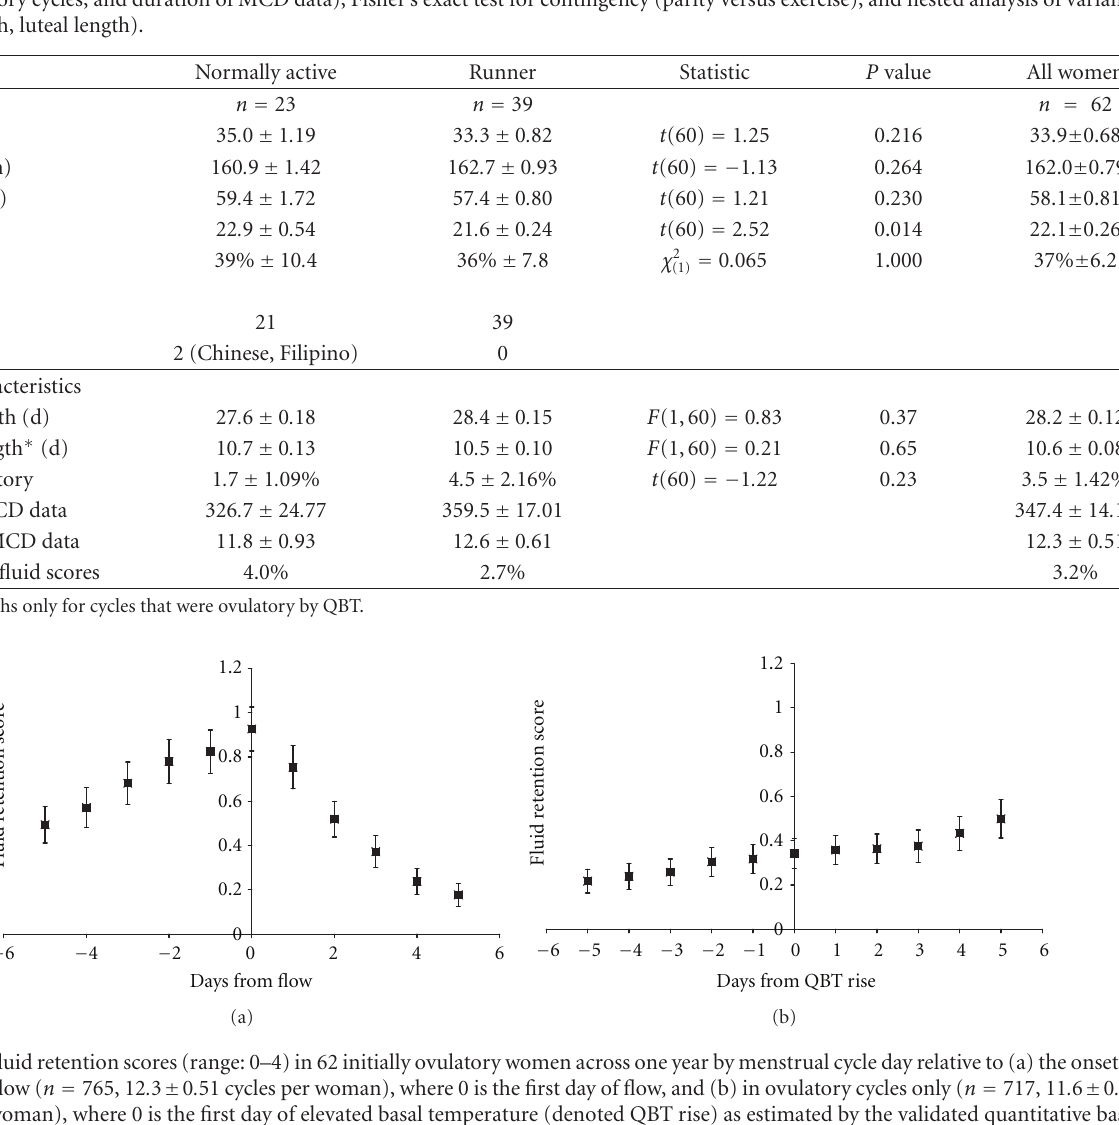
Table 1: Demographic and menstrual cycle information for 62 women with daily Menstrual Cycle Diary (MCD) data. Women were screened to be initially ovulatory and healthy. They participated in a one-year prospective study. The women are shown in two groups: normally active women did less than an hour of aerobic activity a week ( n = 23) and runners include those training for a marathon plus those running for health and fitness ( n = 39). Data are presented as mean ± SE. Statistical analyses are by t -test (age, height, weight, BMI, menarche, proportion of anovulatory cycles, and duration of MCD data), Fisher’s exact test for contingency (parity versus exercise), and nested analysis of variance (cycle length, luteal length).